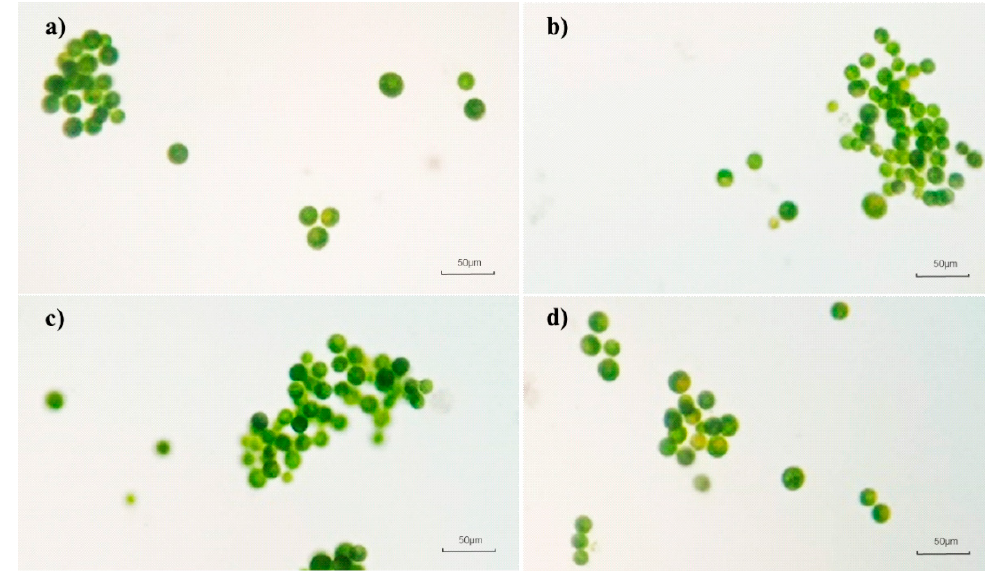
Figure 7. Cell morphology of H. pluvialis at different initial biomass densities—3.5 ( a ), 5.0 ( b ), 6.5 ( c ), and 8.0 ( d ) g·m − 2 —after 10 days of growth in a twin-layer porous substrate photobioreactor (TL-PSBR) with a light intensity of 80 µmol photons m − 2 ·s − 1.